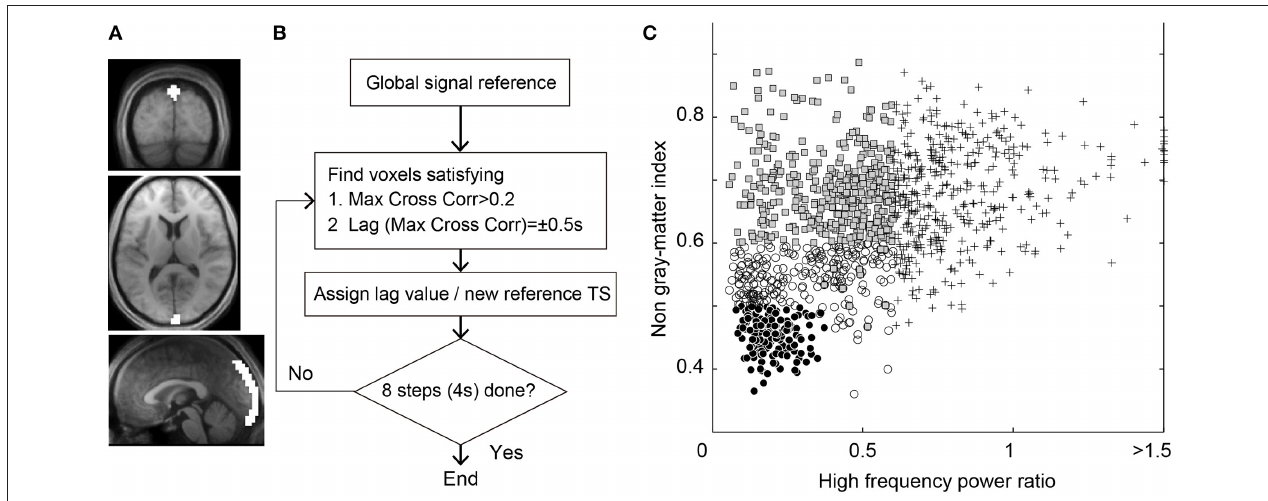
FIGURE 1 | (A) Region of interest for the seed time series of Lag-SSS covering the posterior part of superior sagittal sinus. (B) Schematic diagram of Lag-rec mapping procedure. (C) Scatterplot of the 1,224 components from the individual ICA for denoising. Components regressed out in Dn1 owing to high temporal frequency power (crosses), those additionally removed in Dn2 (shaded rectangles) and in Dn3 (open circles), and the “signal” components surviving the Dn3 filtering (filled circles) are